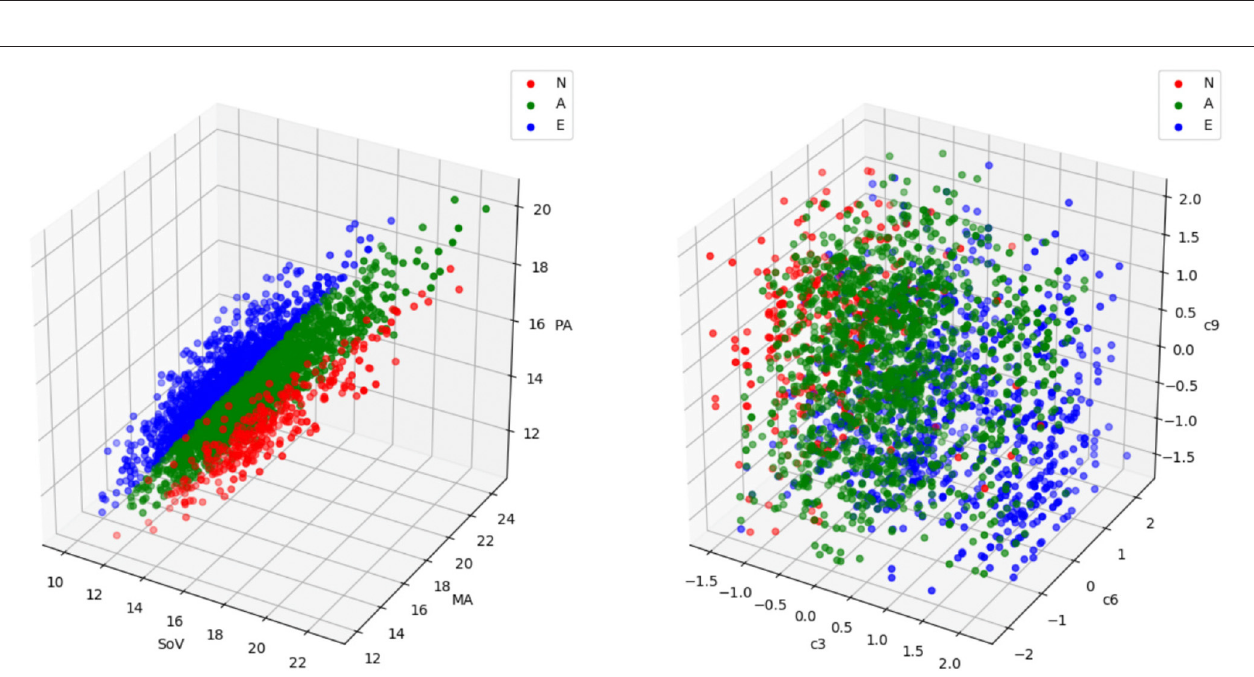
FIGURE 1 | Geometric biomarkers and phenotypes used in the study. Left, graphical representation of some of the considered anatomical biomarkers superimposed on the anatomy of an aorta. Right, the three phenotypes defined by Schaefer et al. (2008), that are used in the clinically-driven cohort generation. The reader can refer to Table 1 for the detailed meaning of the acronyms.